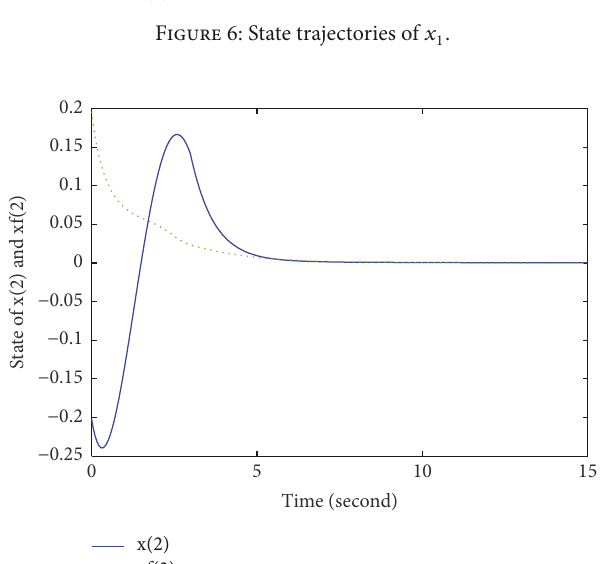
Figure 6: State trajectories of 𝑥 1 .